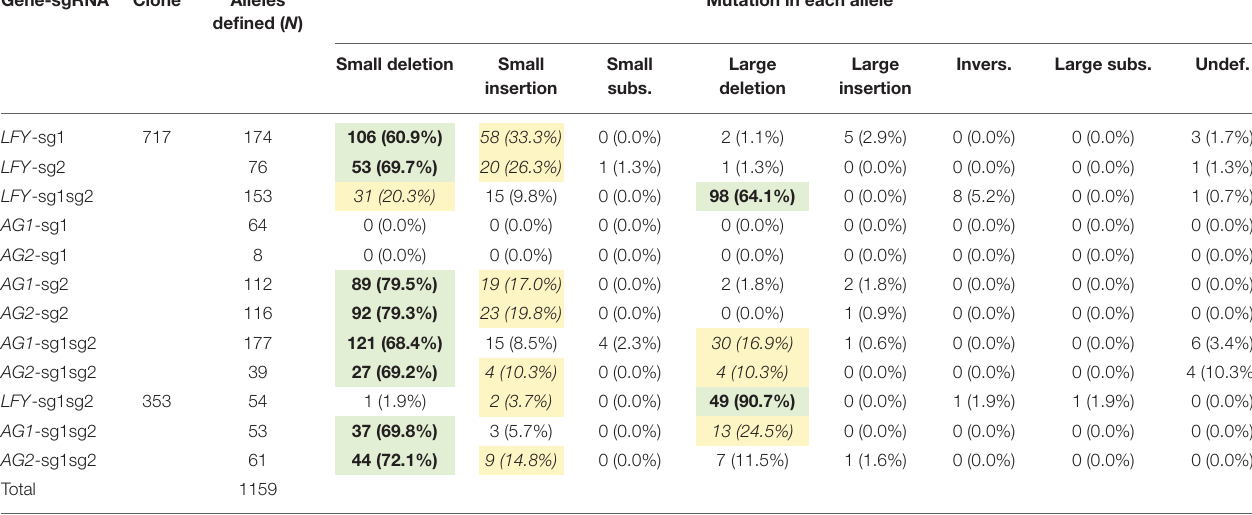
TABLE 2 | Mutation types. Gene-sgRNA Clone Alleles